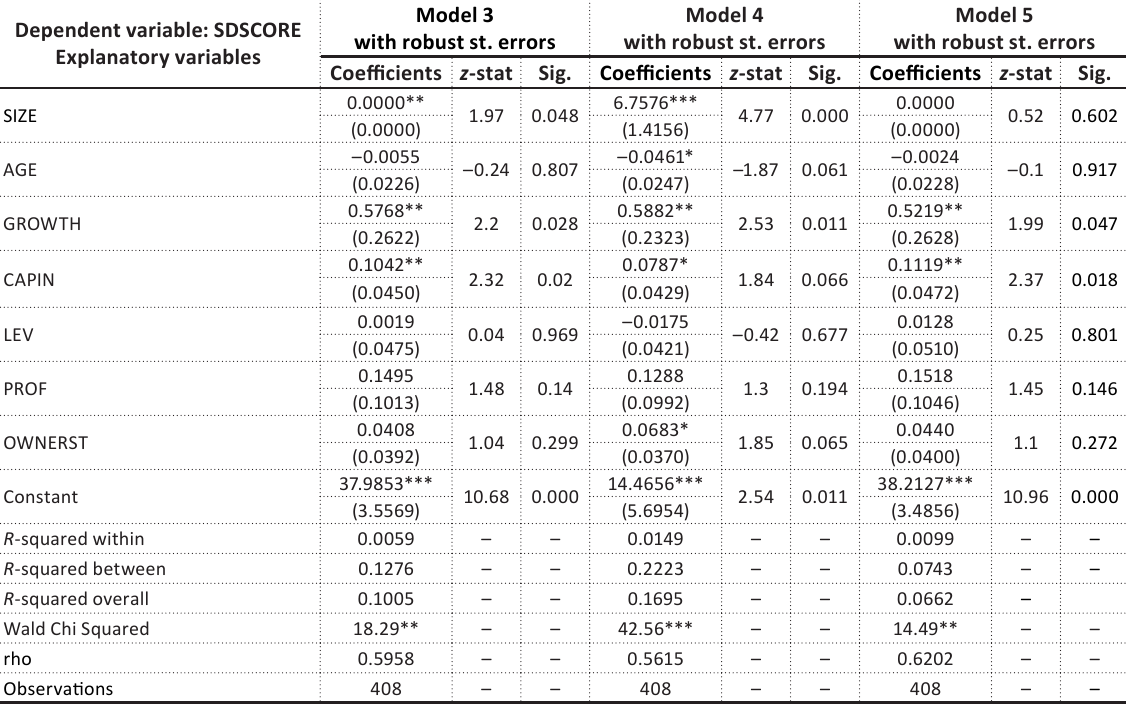
Table 6. Robustness check 2: regression models with different proxies for firm size without